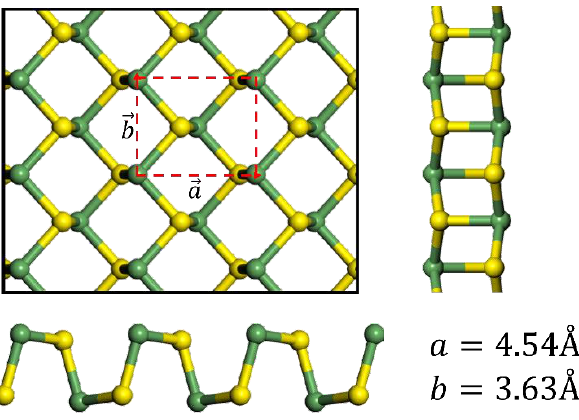
Figure 1. Structure and lattice parameters of the pristine GeS layer. Germanium and sulfur atoms are represented by green and yellow balls, respectively. The 1 × 1 unit cell is marked with the red box.